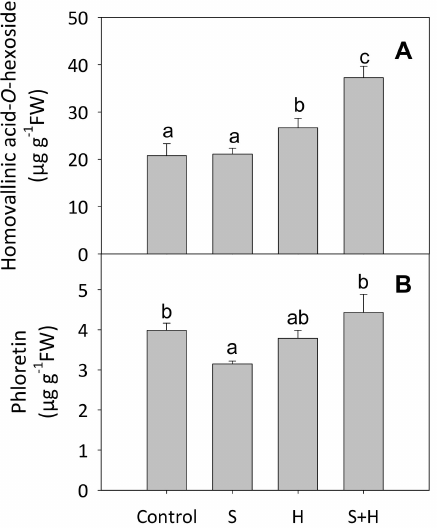
Figure 4. Concentration of homovanillic acid- O -hexoside ( A ) and phloretin ( B ) ( µ g g − 1 fresh weight) in tomato fruits under control (C), saline (S) and heat conditions (H) or the combination of salinity and heat (S + H). Values are means ± SE ( n = 6). Different letters indicate significant differences between means according to Duncan’s test at the 5%